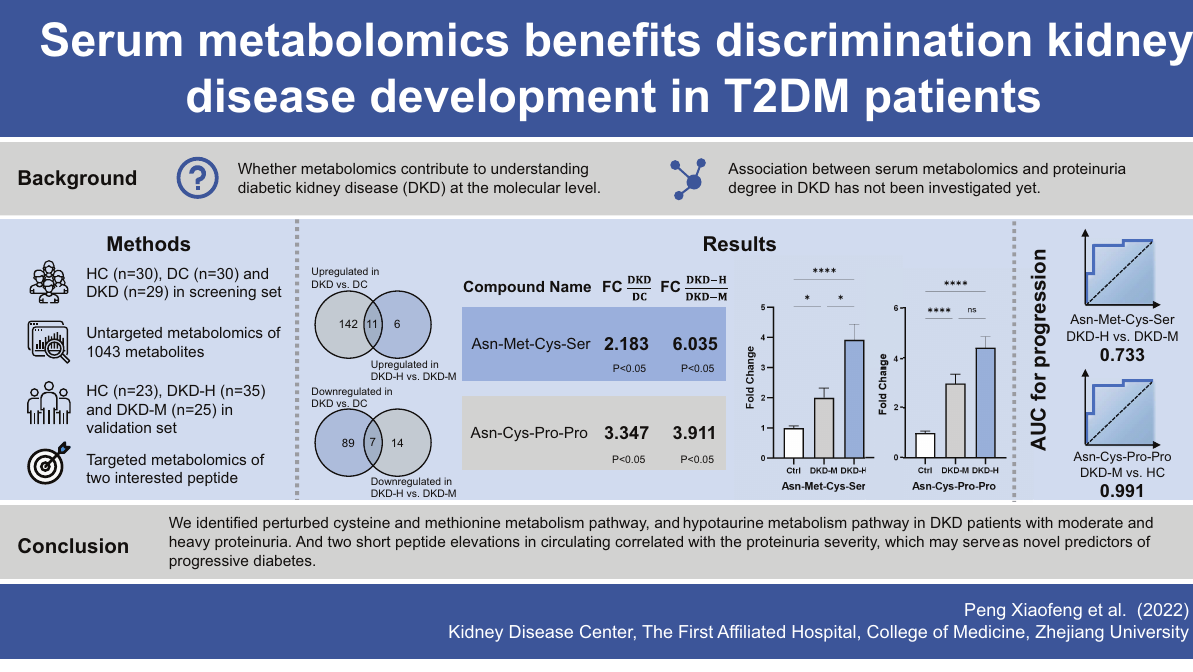
FIGURE 7 | Schematic illustration of the present